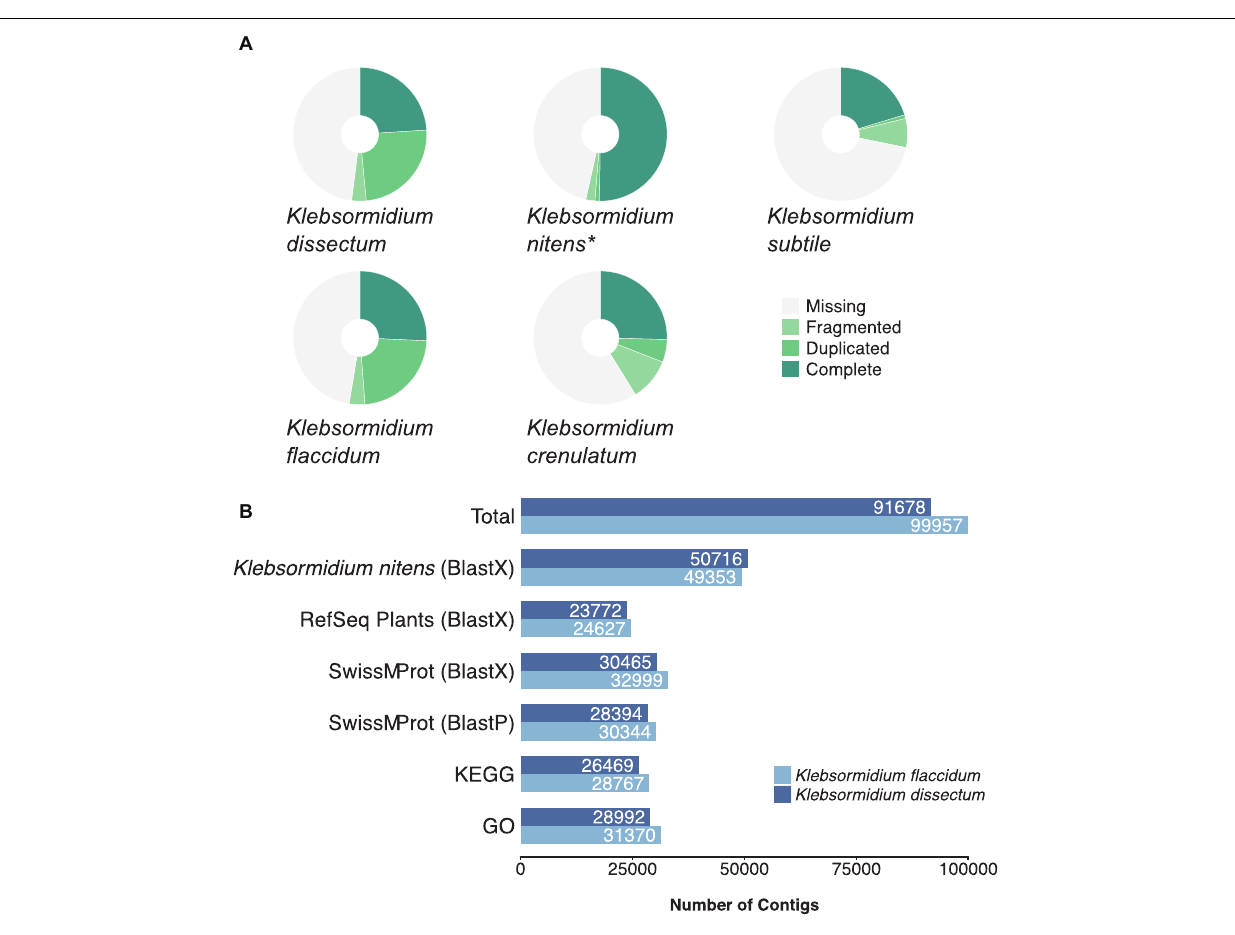
FIGURE 4 | (A) BUSCO analysis of the assembled transcriptomes from K. dissectum and K. flaccidum . The pie chart displays the results of the BUSCO analysis with the categories complete, duplicated, fragmented, and missing. For comparison the transcriptomes of K. crenulatum and K. subtile , as well as the genome (indicated with an asterisk) of K. nitens were included in the BUSCO analysis. (B) Summary of the annotation results for K. dissectum and K. flaccidum . The assembled contigs were blasted against the genome of K. nitens and the indicated databases using the indicated BLAST program and an e -value cut-off of E